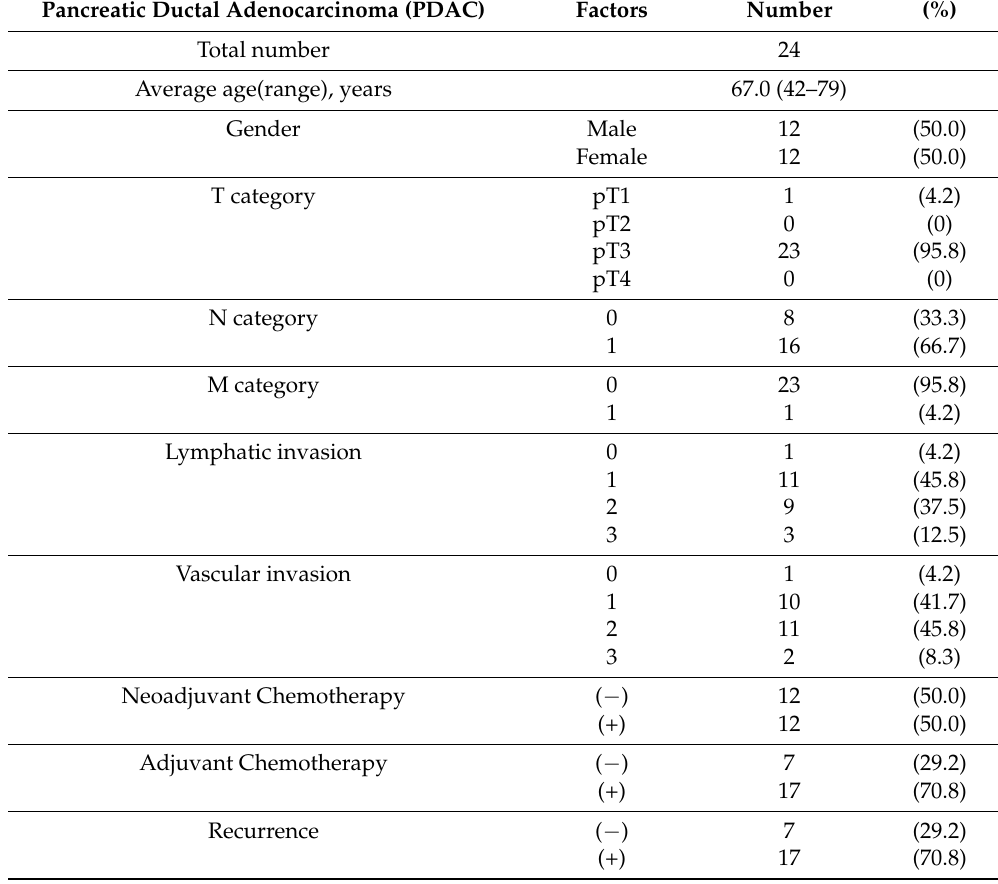
Table 1. Patient characteristics.